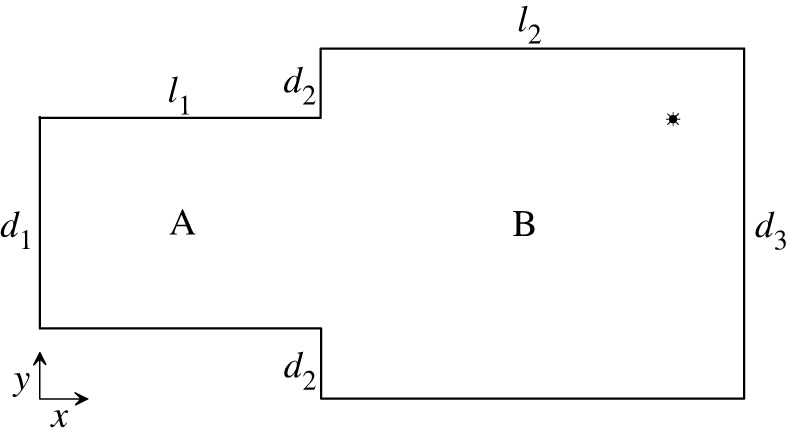
Horizontal plan view of examined system of coupled spaces consisting of two connected rectangular subspaces A and B. Symbol shows position of point sound source.